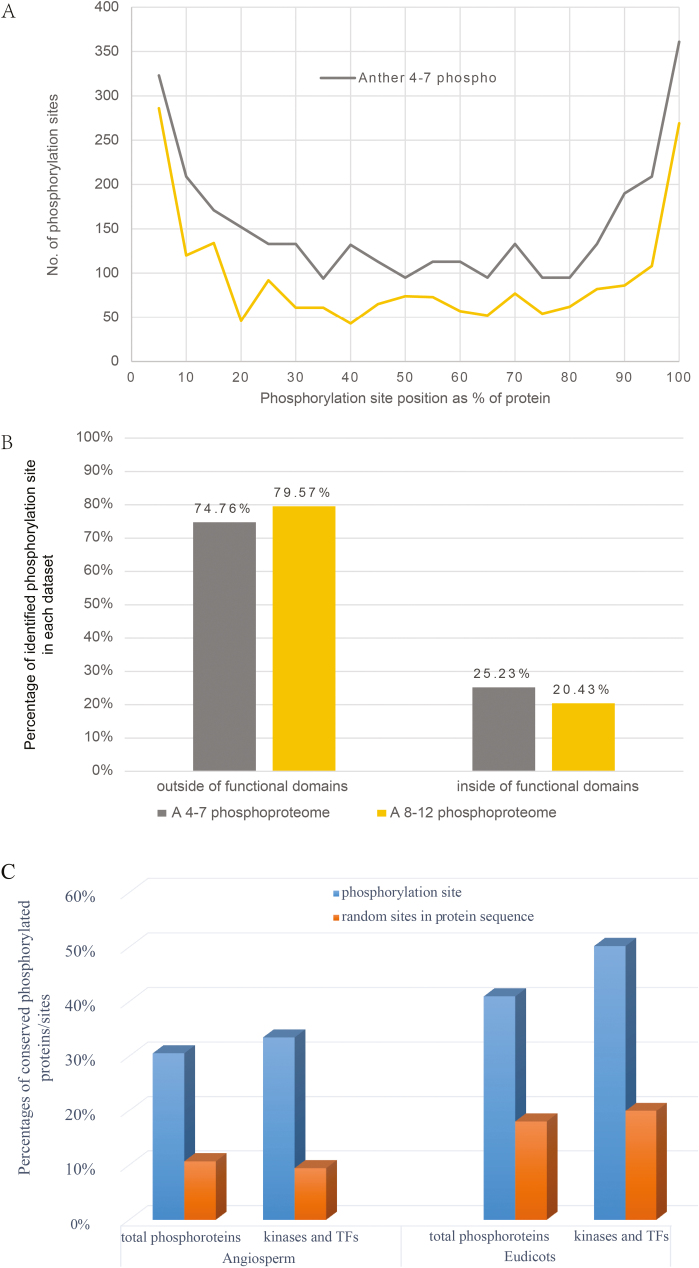
Analysis of identified phosphorylation sites. (A) Positional distribution of the identified phosphorylation sites in protein sequences. In this analysis, each protein sequence was evenly divided into 100 fractions and every five fractions were set as one unit, and then the number of phosphorylation sites within each unit was calculated. Phosphorylation preferentially occurred in the protein terminus (N-terminus or C-terminus). (B) Comparison of the phosphorylation sites located inside and outside the region of the functional domains (predicted by Pfam) of the phosphoproteins. Phosphorylation preferentially occurred in the unconserved linker regions. (C) Conservative analysis of phophorylation sites across eudicots and angiosperm.